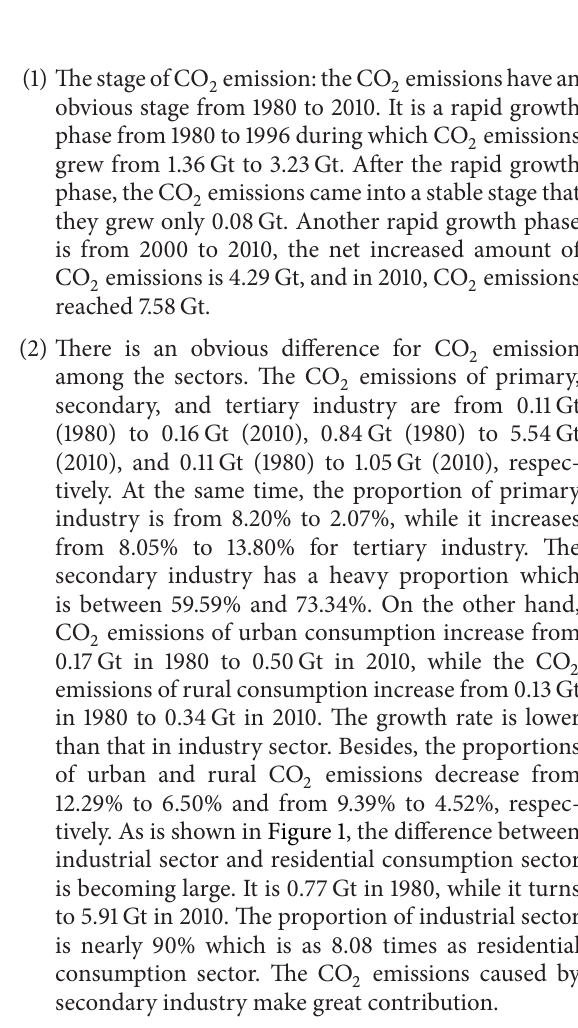
Table 7 is the decomposition results of efficiency